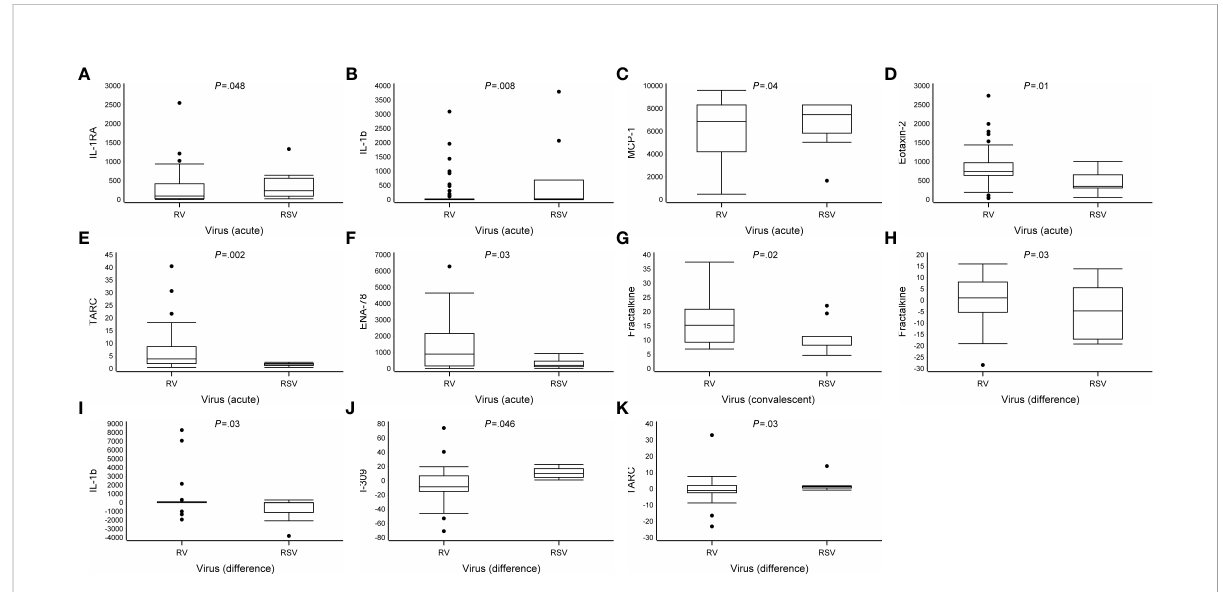
FIGURE 2 Differences in cytokine expression levels at study entry and convalescent phases. Data are presented as median [the lower (Q1) and upper (Q3) quartiles, and data falling outside the Q1 – Q3 range are plotted as outliers]. Cytokine concentrations are presented as pg/ml. In the difference in the cytokine expression, multiple signi fi cant differences were observed between virus groups (RV vs. RSV, all P <.05) (A – K)